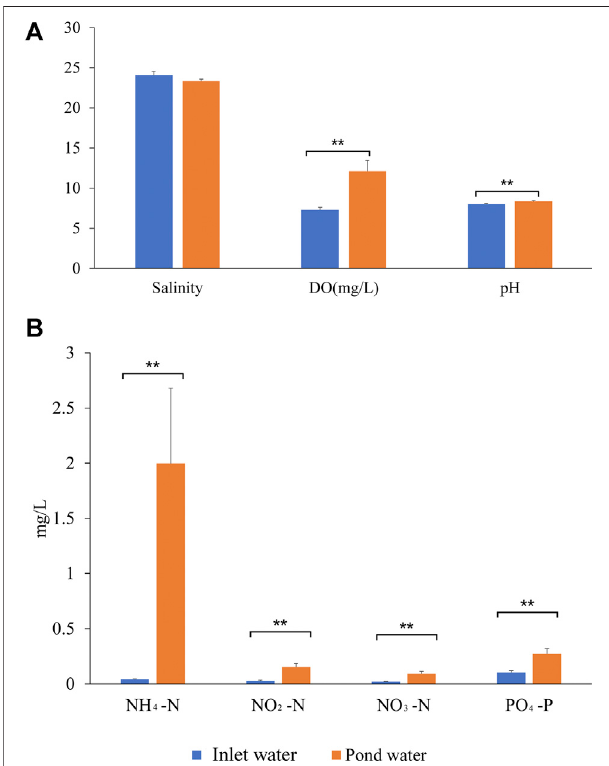
FIGURE1| Physico-chemicalparametersofpondwaterandinletwater. (A) comparisonofsalinityDO,andpHbetweeninletwaterandpondwater; (B) comparison of nitrite-N, nitrate-N, ammonium-N and phosphate-P concentrationsbetweeninlet waterand pondwater; Asterisksrepresent signi fi cance analysis ( p <